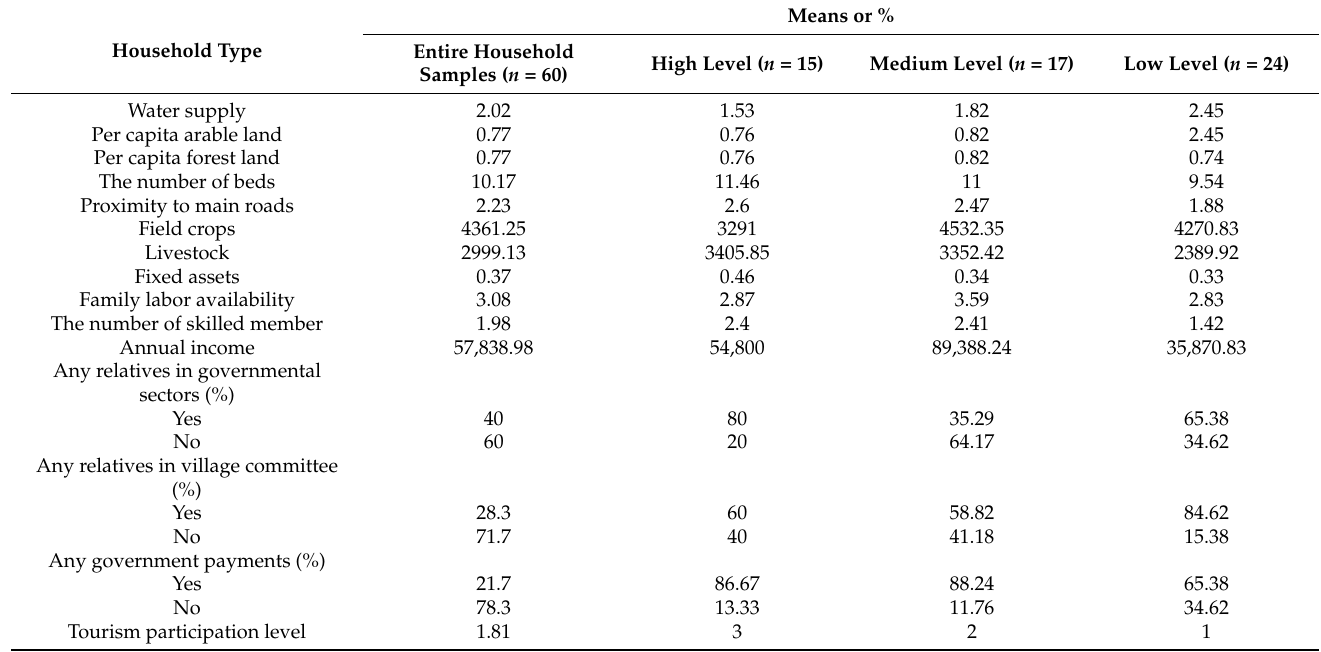
Table 3. Descriptive statistics for all categories of variables